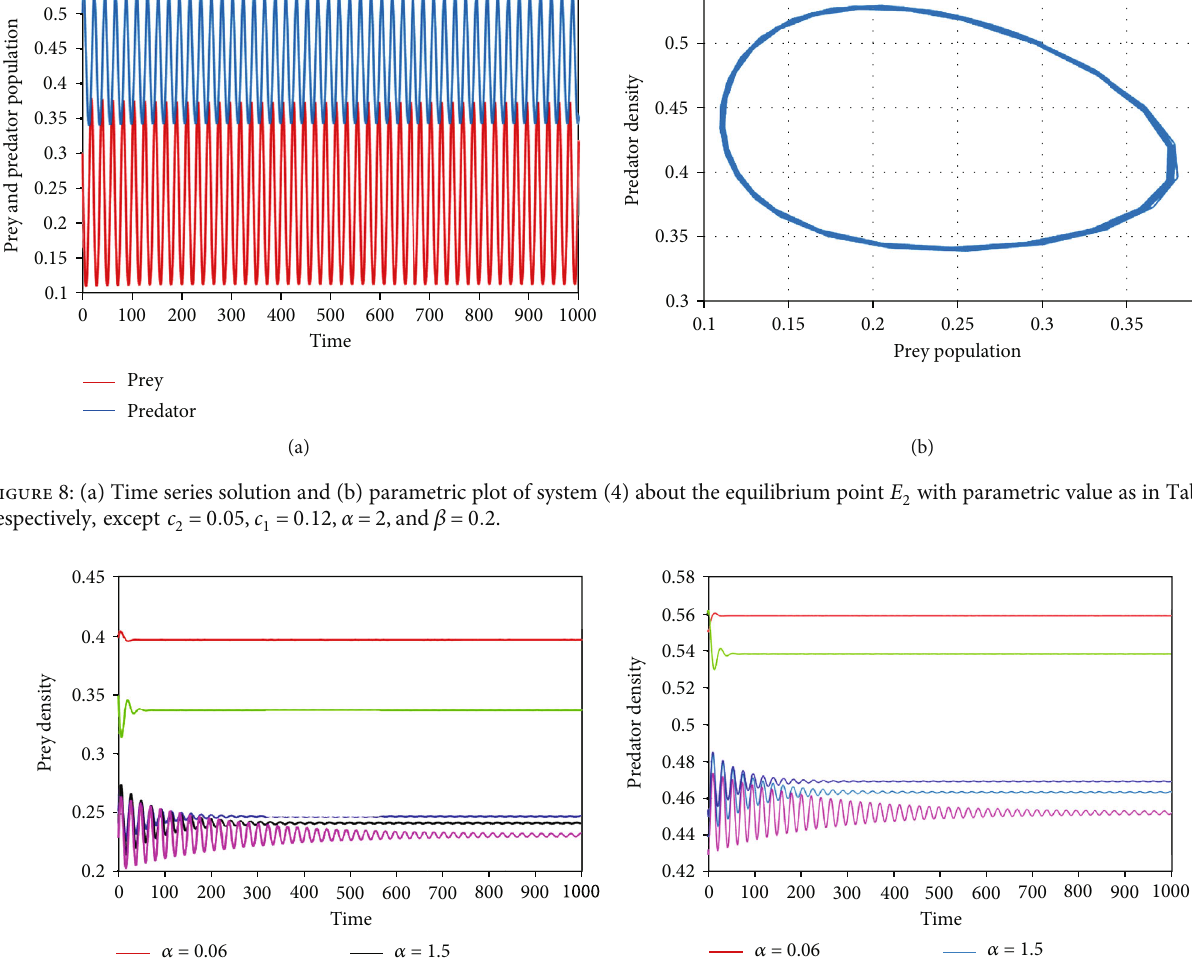
Figure 9: (a) The density of prey population for the parameter values as in Table 2 except ð c ð c 2 = 0 : 05 Þ . (b) The density of predator population for the parameter values as in Table 2 except ð c 1 = 0 : 12, ð α = 0 : 06, 0 : 4, 1 : 4, 1 : 7 Þ , β = 0 : 2 Þ and c 2 = : 05 .